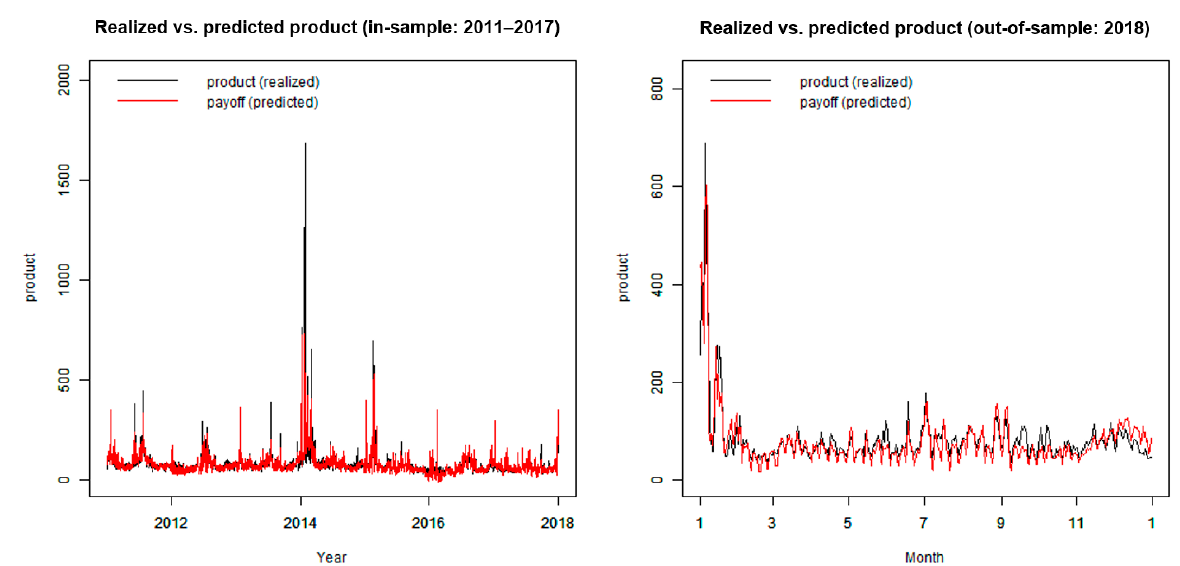
Figure A3. Comparison of realized and predicted values for the product model.